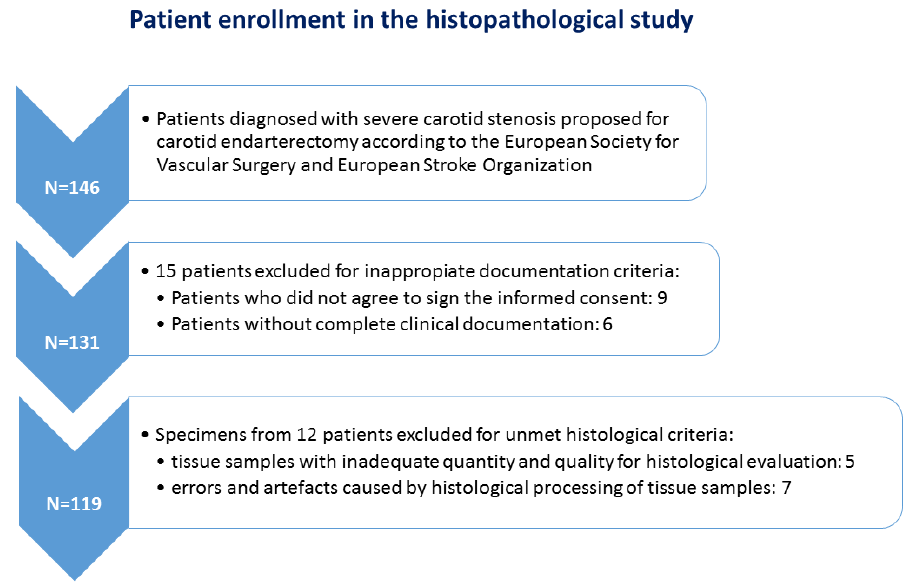
Figure 1. Flowchart of the study.